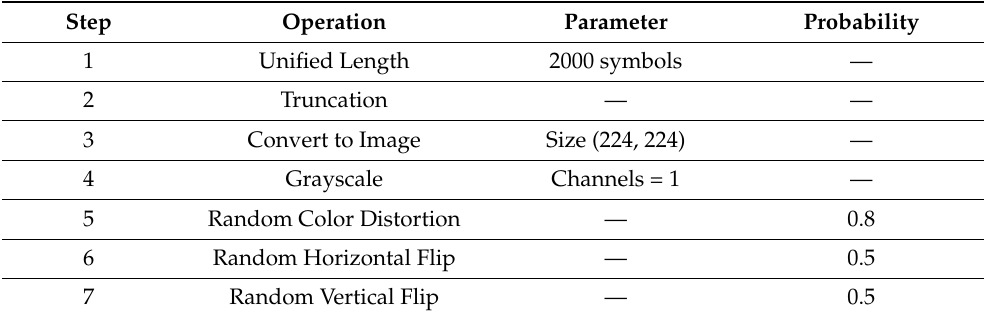
Table 1. Stochastic data augmentation and parameters setting.